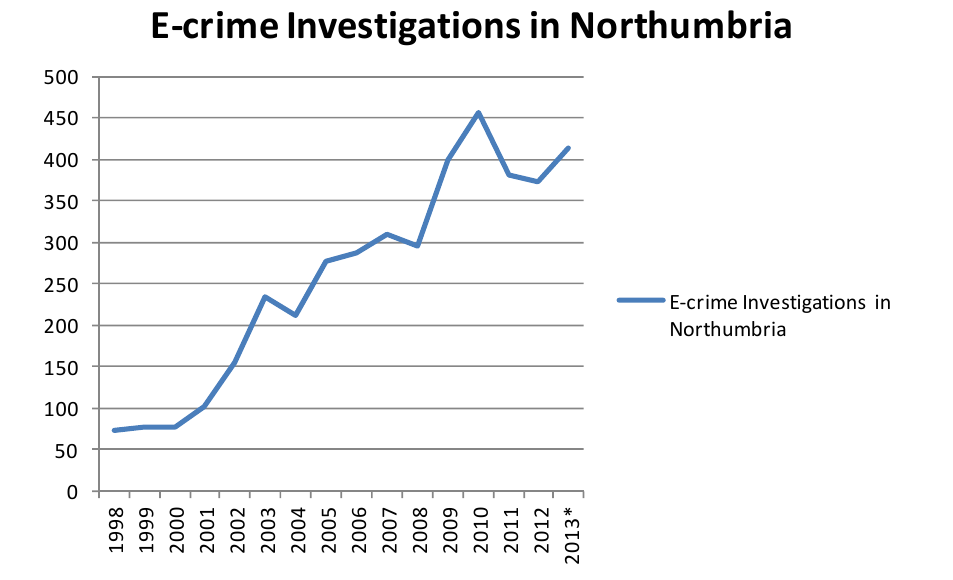
Figure 1. Ecrime Investigations in Northumbria Police region 1998–2013. Please note 2013 data only available for first three quarters and shown figure has been adjusted to reflect all year anticipated investigations (310 reported ecrimes to end